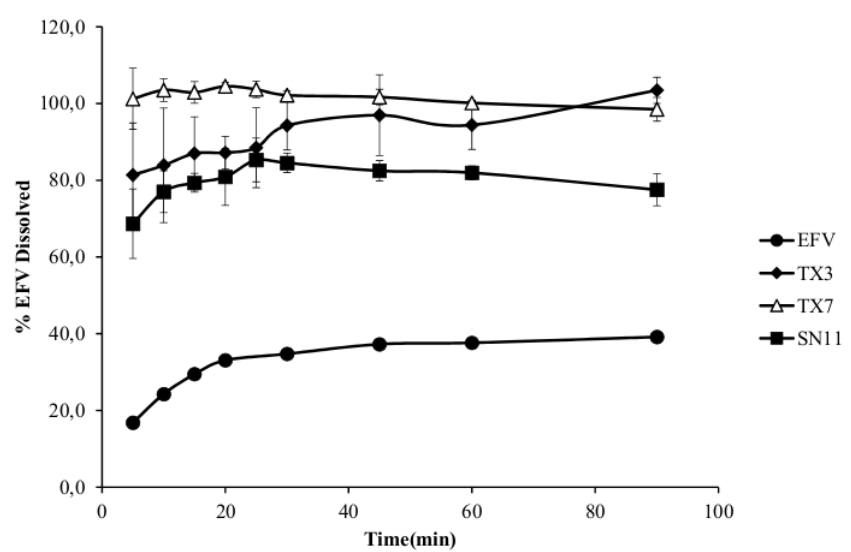
FIGURE 6 - Comparison between dissolution profiles of samples TX3, TX7, EFV and sonication sample (SN11). Comparison of dissolution profiles of the most promising samples with efavirenz and sample SN11 (from